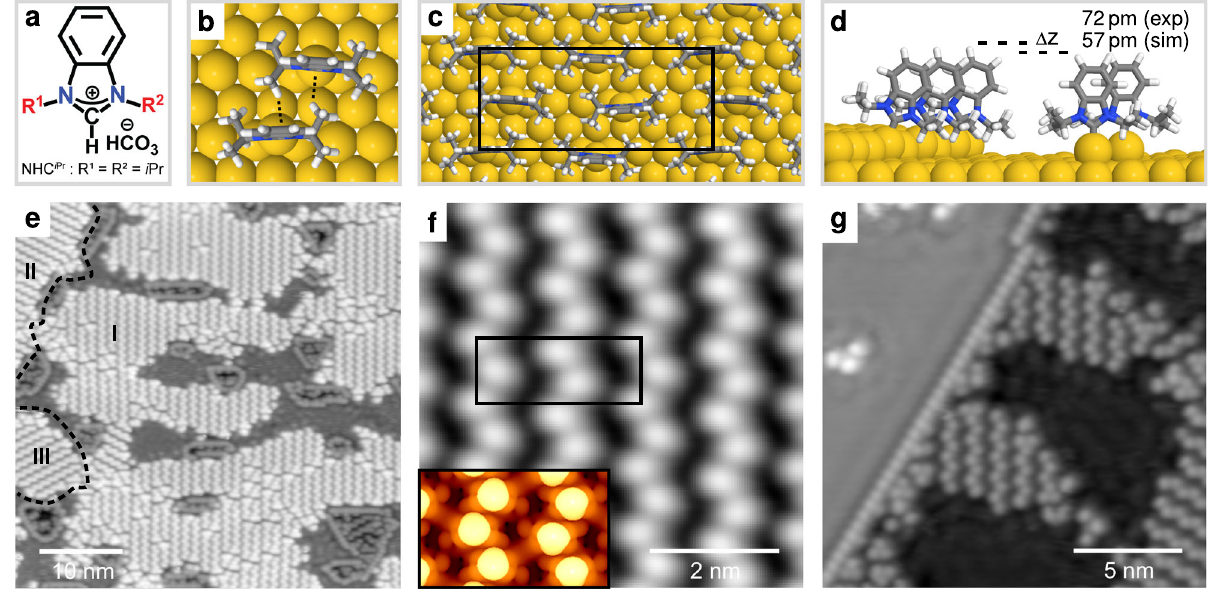
Fig. 1 Adatom-mediated self-assembly of NHC iPr into zig-zag rows stabilized by non-covalent interactions. a Schematic structure of the bicarbonate salt. b CH- π interactions between NHC iPr molecules on Au(111). c Model of the proposed zig-zag lattice. d Model showing NHC iPr molecules decorating the upper Au(111) step edge together with a zig-zag row on the lower terrace. e Scanning tunneling microscropy (STM) image of zig-zag lattice at 0.8 ML coverage with three domains (details: 20 pA tunneling current, 100 mV sample bias, 48.0 × 48.0 nm 2 scan size, 75 °C anneal temperature). f Detail of the zig-zag lattice (80 pA, 50 mV, 6.0 × 6.0 nm 2 , 75 °C). The inset shows an STM simulation of the proposed zig-zag lattice. g NHC iPr molecules decorating the upper Au(111) step edge together with a zig-zag lattice on the lower terrace (20 pA, 100 mV, 18.0 × 18.0 nm 2 , 125